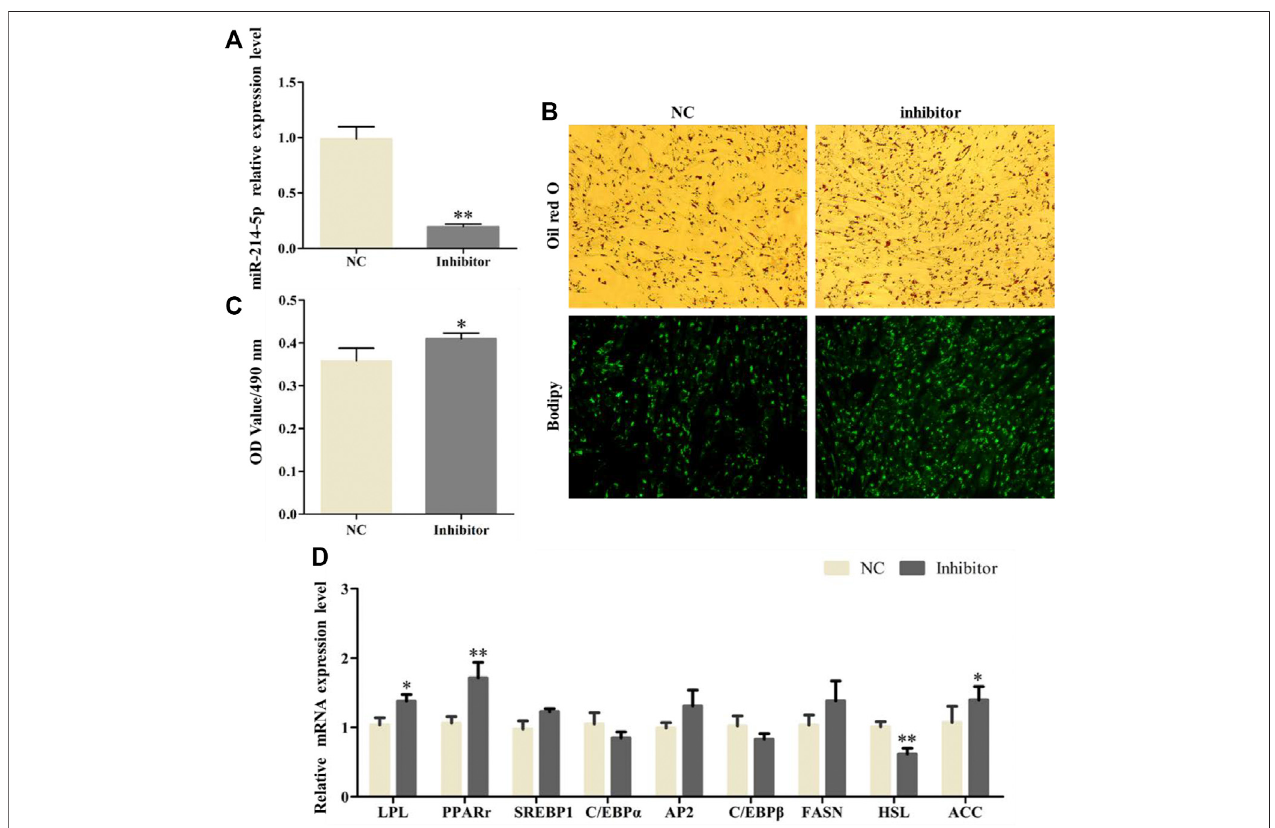
FIGURE 2 | Inhibiting miR-214-5p promoted goat intramuscular adipocyte differentiation. (A) Ef fi ciency of the miR-214-5p inhibitor. (B) Oil red O staining and Bodipy staining ( × 200). (C) OD value at 490 nm. (D) mRNA expression levels of key adipogenic regulatory genes after transfection of the miR-214-5p